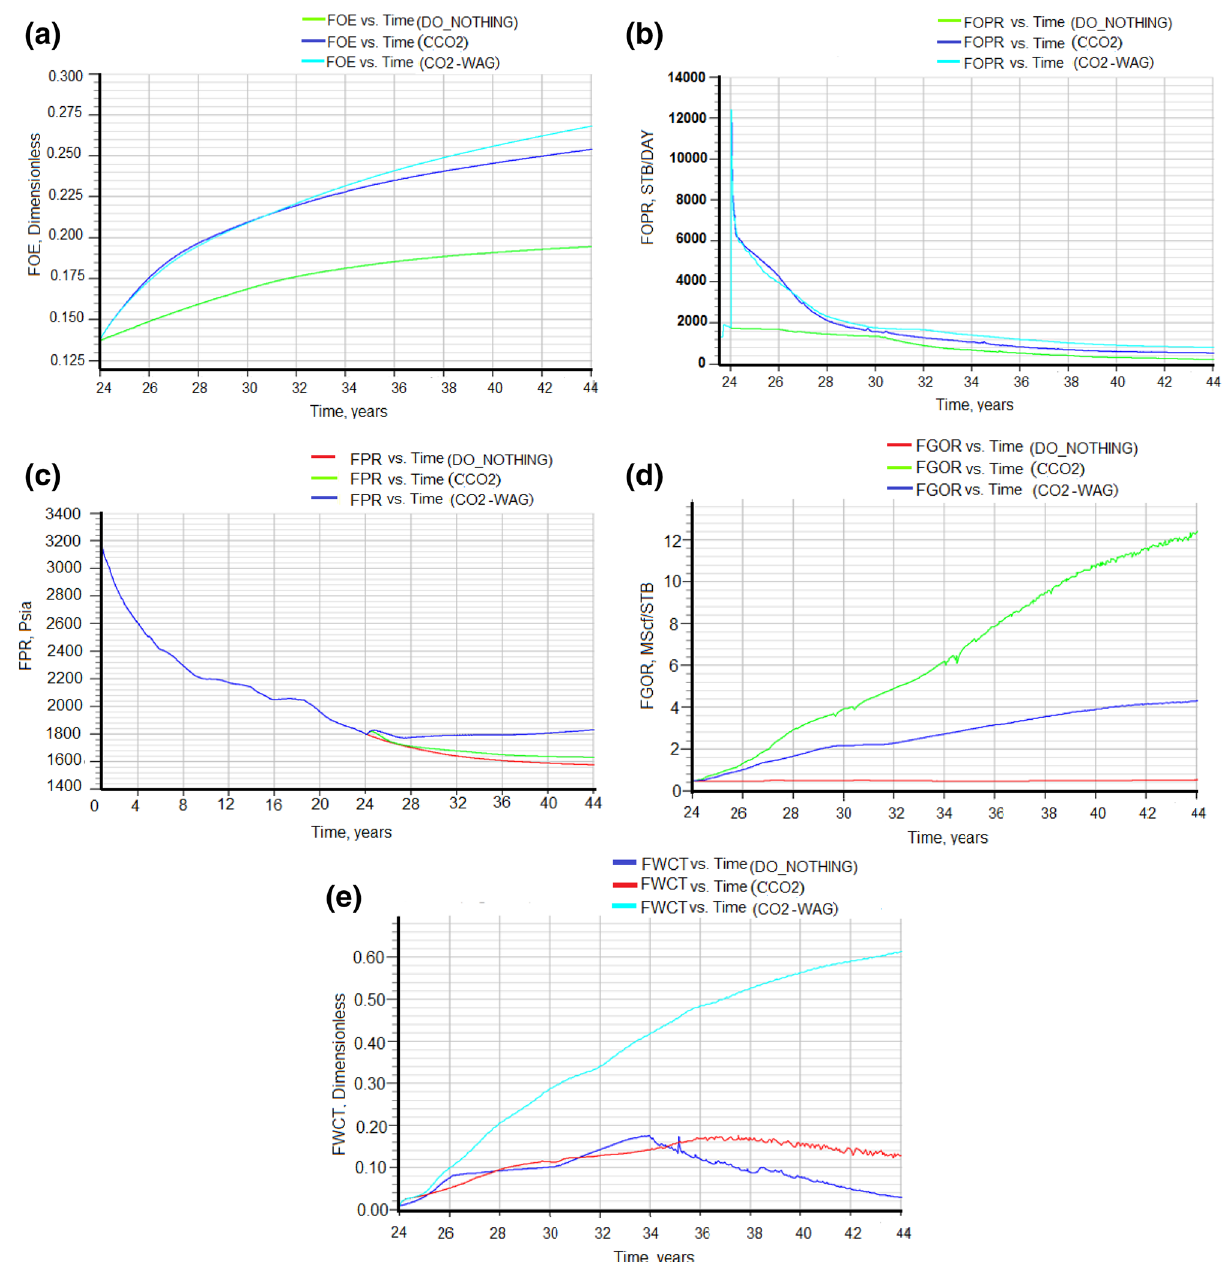
Fig. 8 Comparison among Do_Nothing, CCO 2 , and CO 2 -WAG injection cases for a FOE, b FOPR, c FPR, d FGOR, e